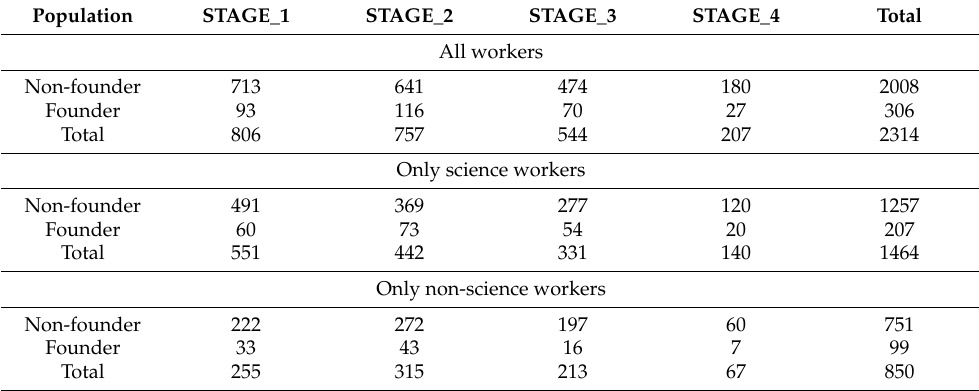
Table 2. Population used in the